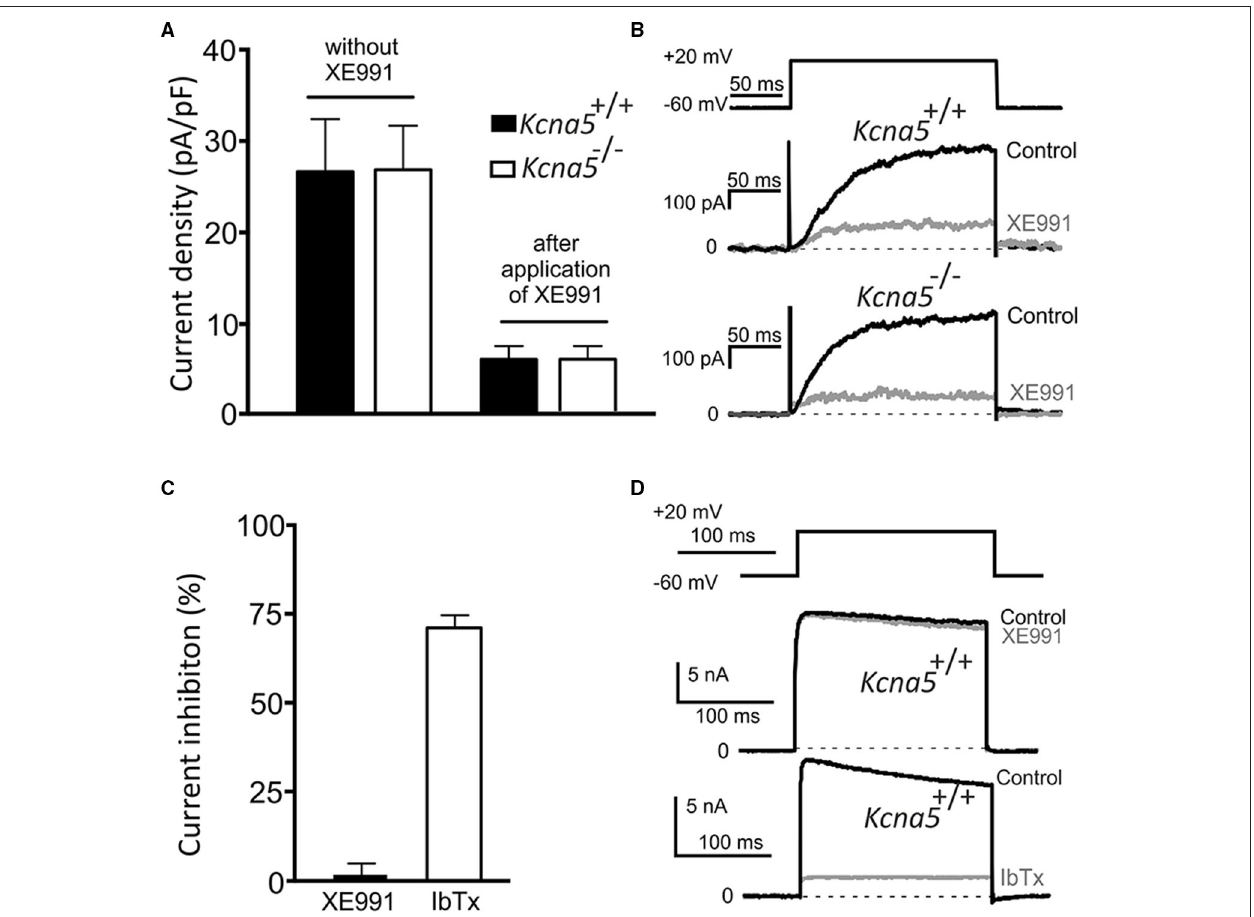
FIGURE 3 | Voltage dependent (K V ) K + currents and BK Ca currents in freshly-isolated mesenteric artery vascular smooth muscle cells (VSMCs) from Kcna5 − / − and Kcna5 + / + mice. K V currents before ( − XE991) and after ( + XE991) application of 30 µ M XE991. Current densities of peak K V currents (A) ( n = 6 Kcna5 − / − cells, n = 10 Kcna5 + / + cells, before and after application of XE991, respectively); original recordings (B) . (C) Relative inhibition of peak BK Ca current by iberiotoxion (IbTx) at 100nM ( n = 5) and XE991 at 30 µ M ( n = 9) in Kcna5 + / + VSMCs, original recordings are represented in (D) .